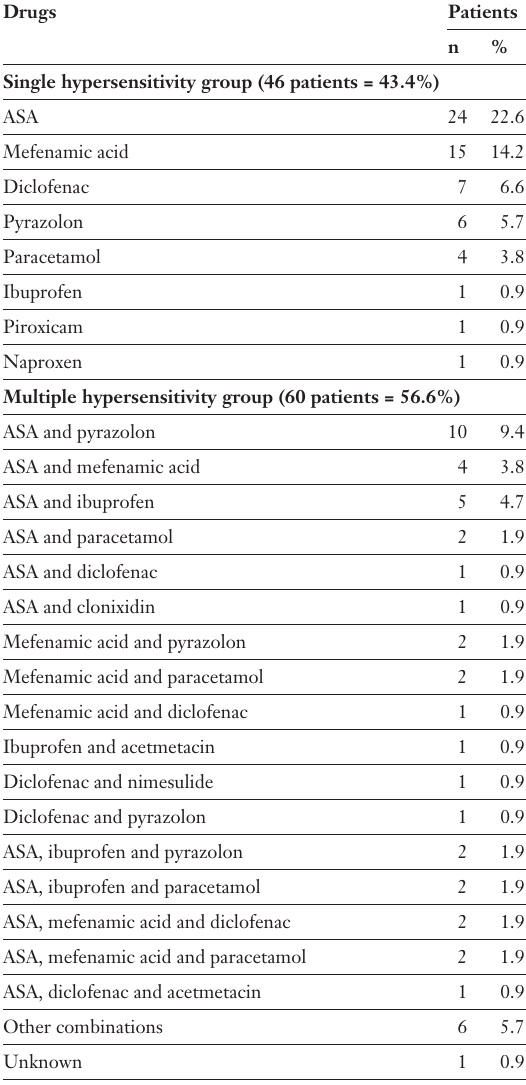
NSAIDs reported to induce intolerance reaction in 106 patients.